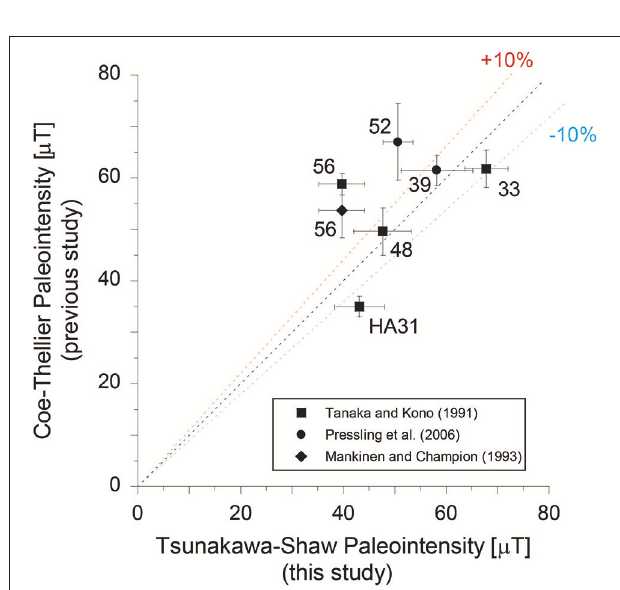
FIGURE 8 | Holocene paleointensity variation in Hawaii based on the TS dataset (red circles, this study), the IZZI dataset (blue squares, Cromwell et al., 2015, 2017), the GEOM-SL dataset (green diamonds, selected from GEOMAGIA50.v3 by Brown et al., 2015), and the CALS10k.2 model (Constable et al., 2016). Error bars indicate one standard deviation.